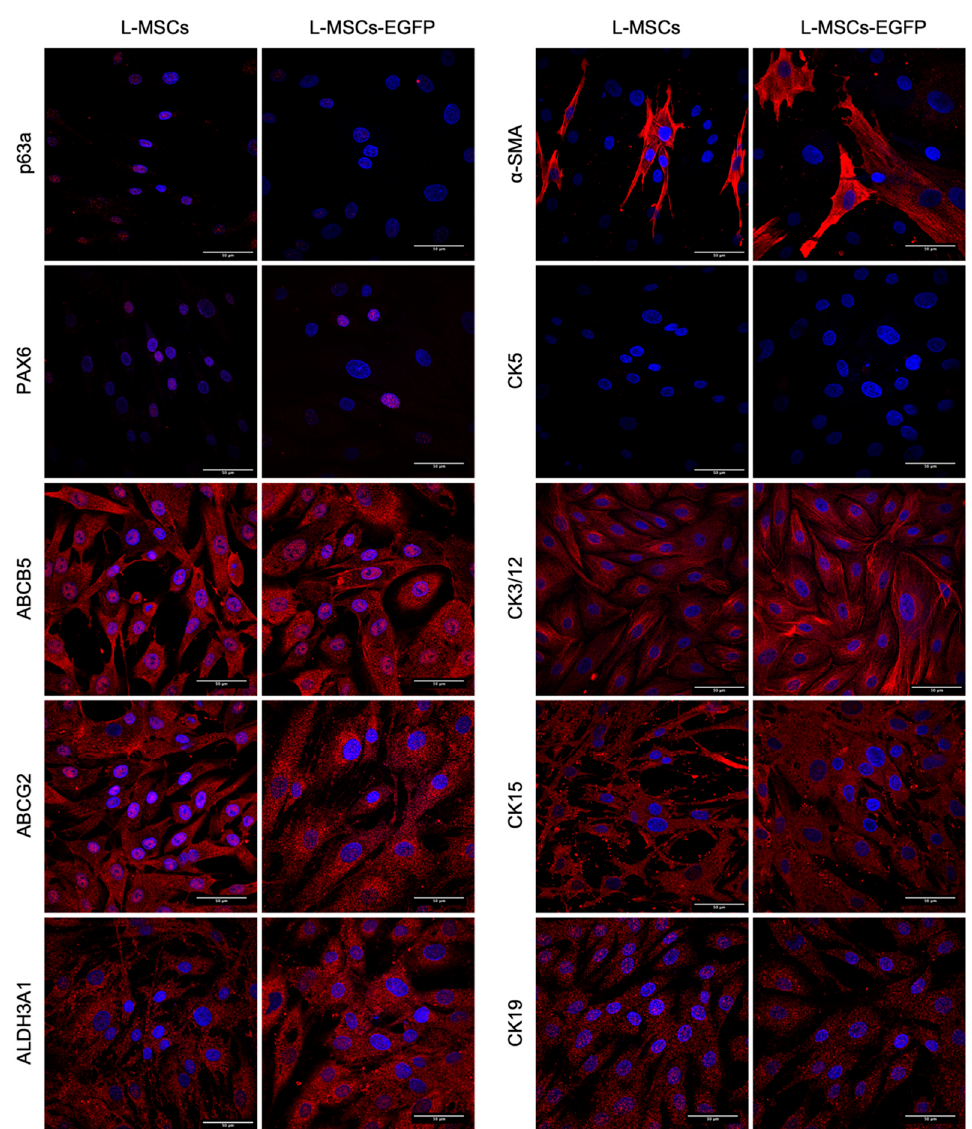
Figure 3. Confocal images of immunocytochemistry assay of L-MSCs and L-MSCs-EGFP. Cells were stained with primary antibodies against stem cells markers (p63 α , PAX6, ABCB5, ABCG2, and ALDH3A1), cells differentiation marker ( α -SMA), and cytokeratins (CK5, CK3/12, CK15 and CK19) and AlexaFluor conjugated secondary antibodies. The nuclei were counterstained with DAPI. Scale bars—50 micrometers ( μ m).